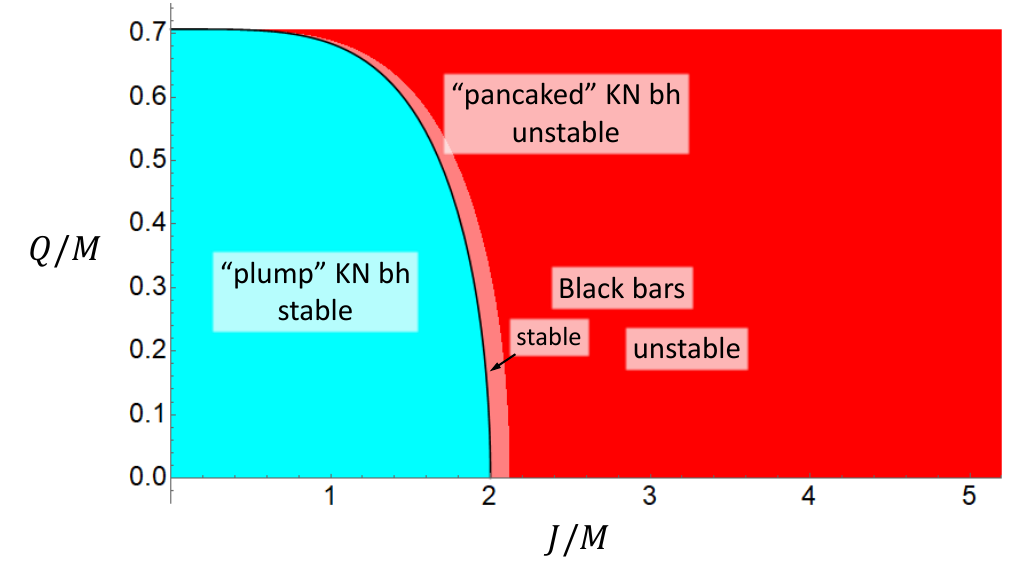
Figure 1 . Phases of the charged rotating black holes constructed in this article to leading or- der in the 1 =D expansion. We label them by their angular momentum J and charge Q for (cid:12)xed p mass M . The charge is bounded above, Q (cid:20) M= 2, but the upper, extremal limit lies outside the strict range of validity of our construction. Kerr-Newman-like (KN) black holes exist for all (cid:0) (cid:1) 1 = 4 J=M . The black line J=M = 2 1 (cid:0) 2( Q=M ) 2 separates the region (blue) where they are sta- ble and round-shaped (\plump"), from the region (red, light and dark) where they are unstable and pancake-shaped (eq. (5.6)). Charged black bars exist in the red regions (section 4.1), but are stable (and only to leading order in 1 =D ) only in the light-red area with outer boundary p (cid:0) (cid:1) 1 = 4 J=M = (3 = 2) 1 (cid:0) 2( Q=M ) 2 (eq. (5.8)). In the upper-left corner there exist near-extremal black holes with arbitrarily small spin (section 3.3): below the black line they are close to the Reissner-Nordstr(cid:127)om solution, approximately spherical and stable; above the black line they are unstable and highly